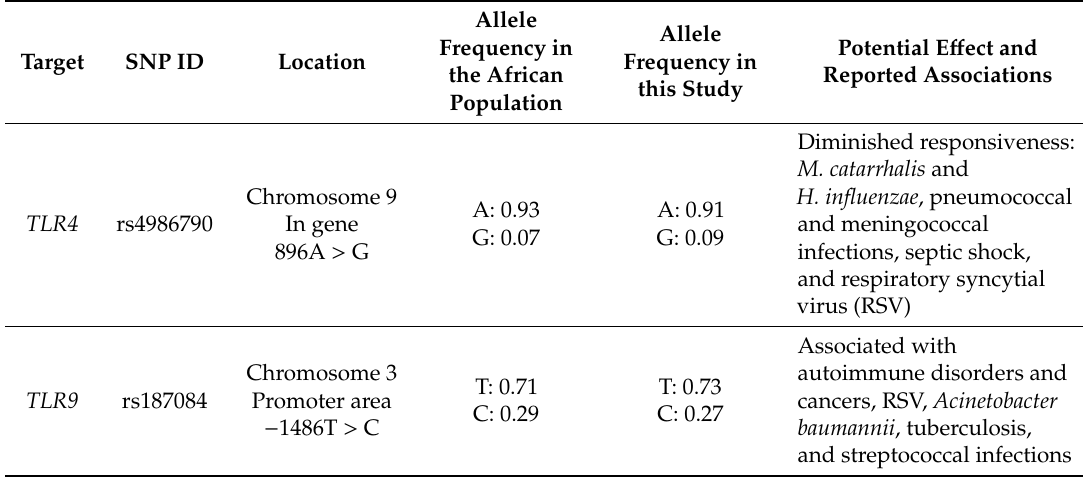
Table 1. Functions of the analyzed single-nucleotide polymorphisms (SNPs) and allele frequencies in the African